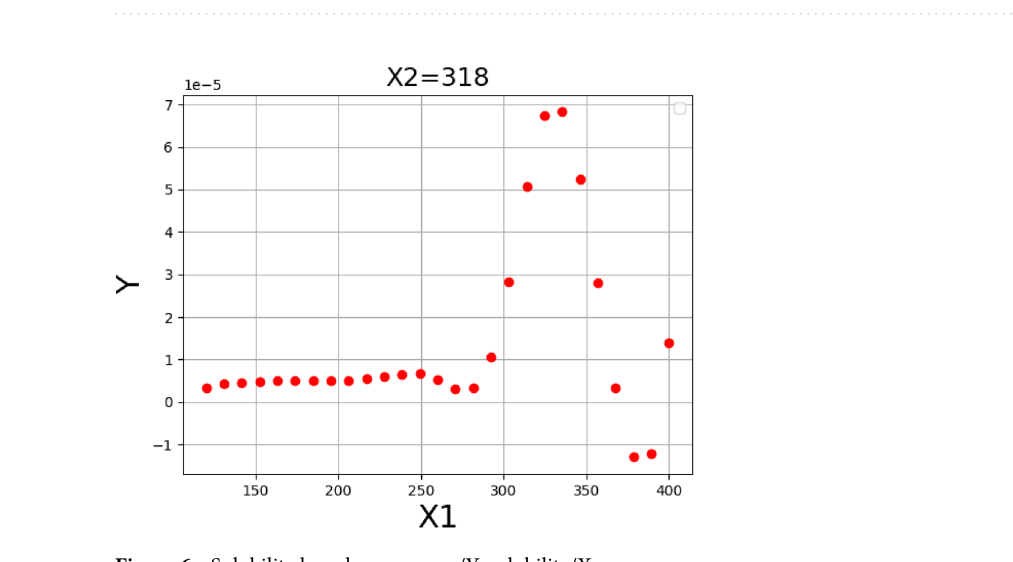
Figure 5. 3D demonstrateion of inputs/outputs/Y: solubility/X 2 : temperature/X 1 : pressure.